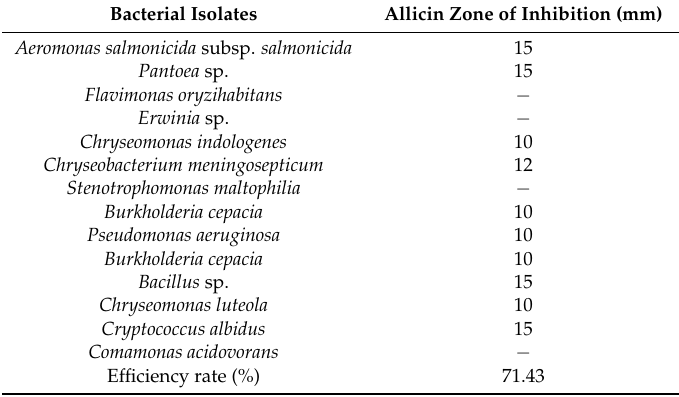
Table 3. The effect of liquid allicin at 50 µ L (disc diffusion) on bacterial isolates as a zone of inhibition